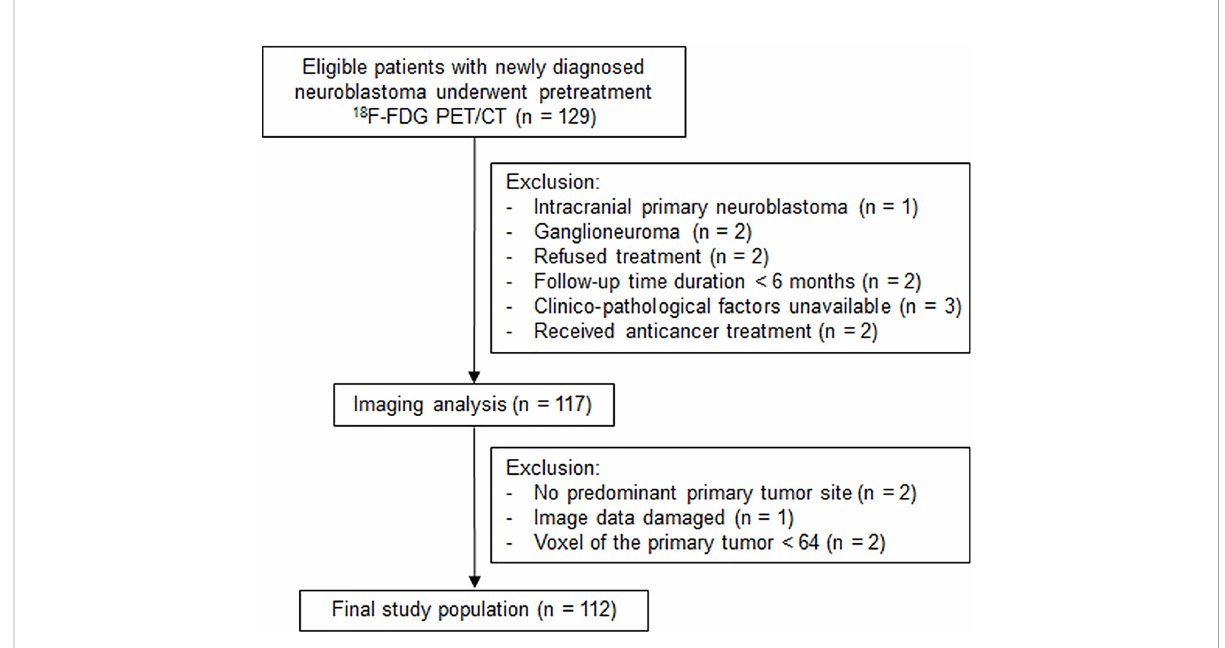
FIGURE 1 Flowchart shows study population selection, with exclusion